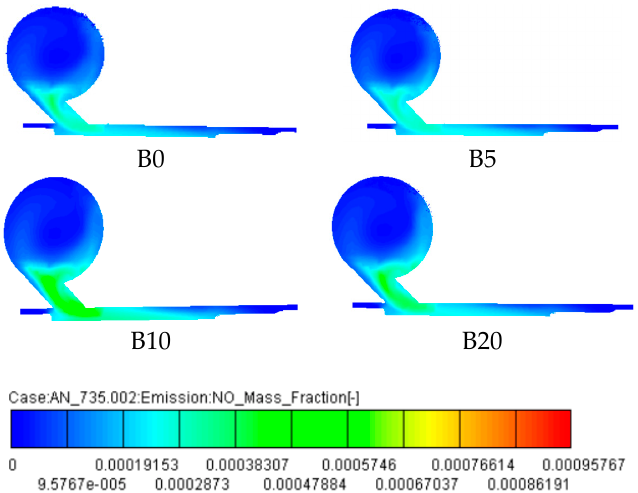
Figure 15. The progress of NOx at 9° ATDC at 1400 rpm and 100% load.